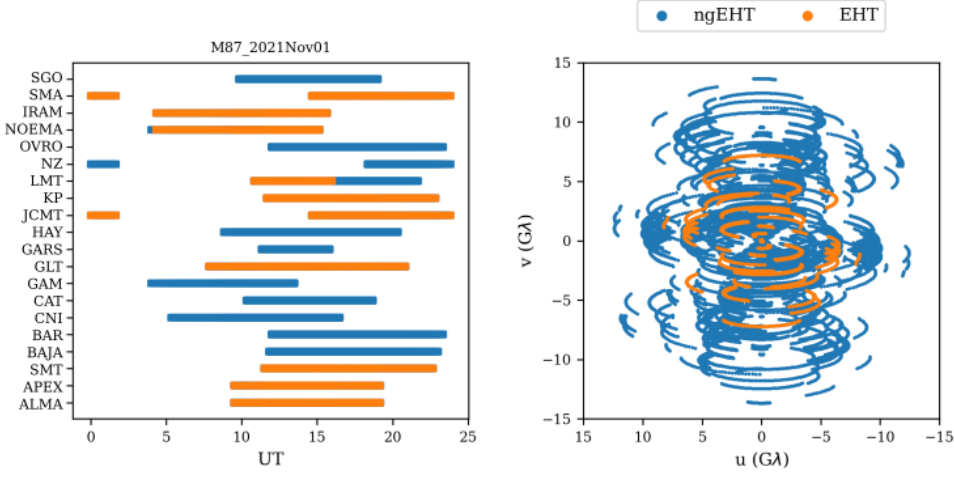
Figure 8. Same as in Figure 7, but for 1 November 2021. Note that, for the LMT, the observation finished at 16:00 UT, which corresponds to the end of night-time at 10:00 a.m. local